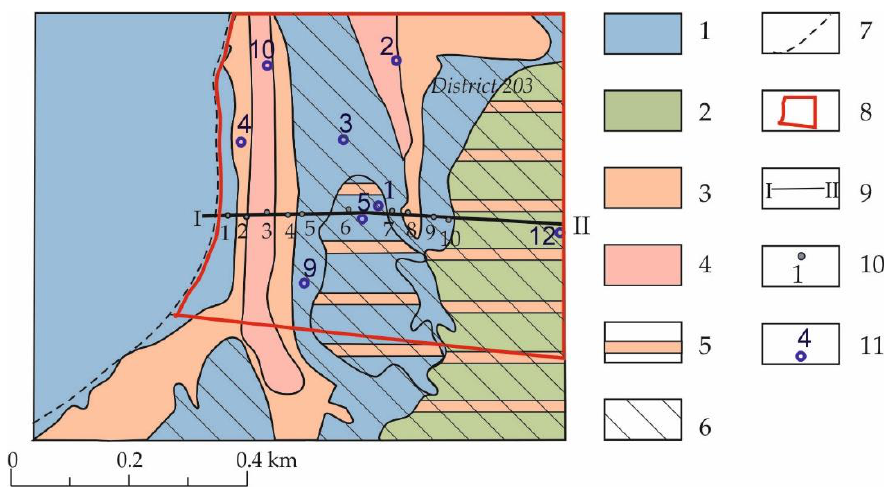
Figure 3. A sketch map showing permafrost conditions in the floodplain during hydraulic fill placement (compiled by Reference [15]): 1 —vertically continuous permafrost (the active layer reaches the permafrost table); 2 —vertically discontinuous permafrost (the permafrost table lies deeper than the base of the active layer with a residual thaw layer of 1.0–1.2 m); 3–4 —taliks confined to lake basins: 3 —thickness <10 m; 4 —thickness 10–15 m; 5 —subordinate distribution of individual taliks <10 m